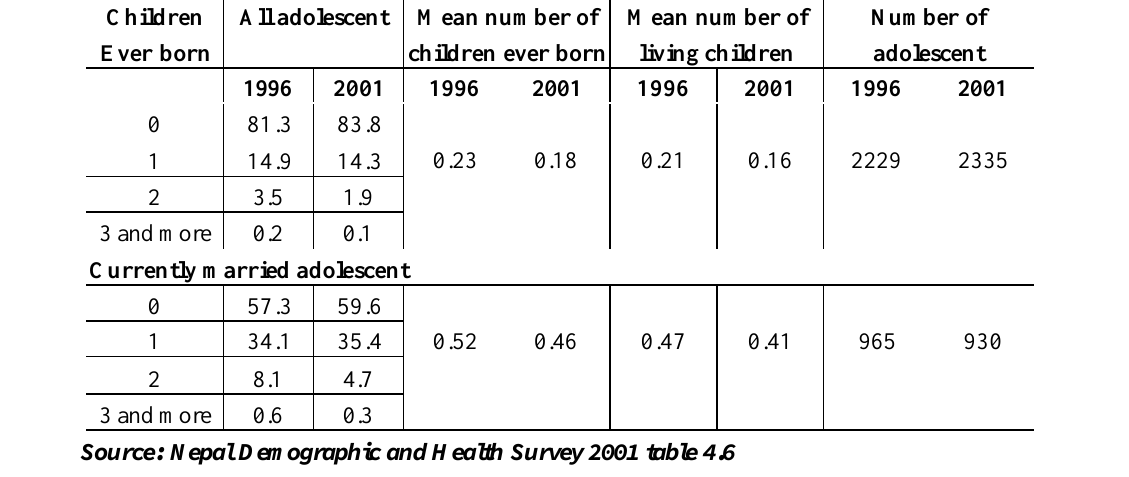
Source: Nepal Demographic and Health Survey 2001 table 4.6